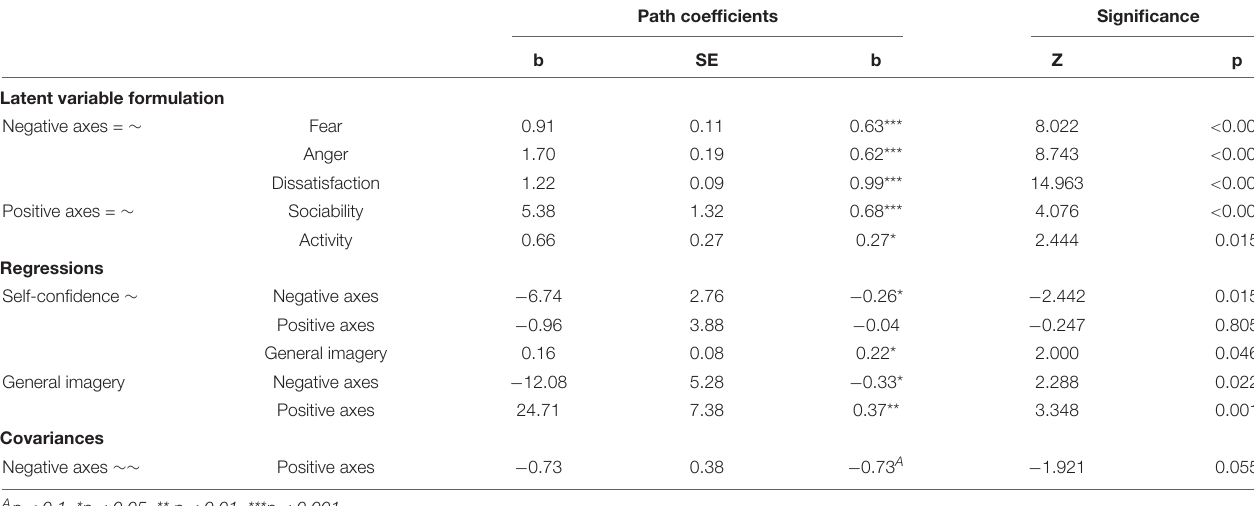
TABLE 3 | Summary of path coefficients.